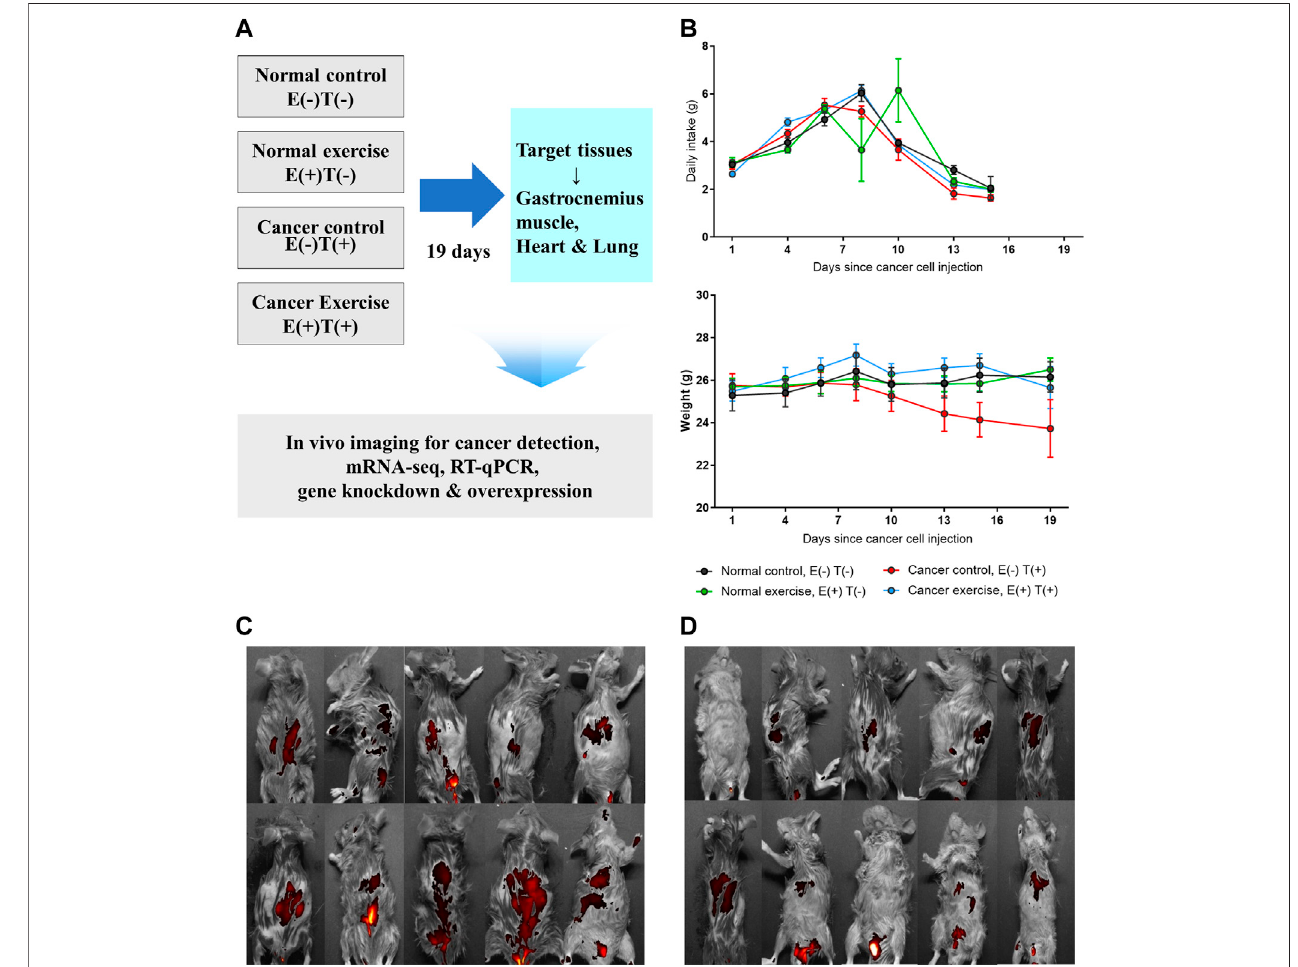
FIGURE1| Invivo animalmodeltostudythemoleculareffectofhigh-intensityaerobicexercise. (A) Inthecurrentstudy,40miceweredividedintofourgroupsoften mice each (normal control, normal exercise, cancer control, and cancer exercise). The changes of daily intake and weight of each group were traced for 19 days. After 19 days, invivo imagesfordetectingCT-26-derivedcancermetastasisweretakenforcancer-bearingmice,andtissueswereisolatedfordetectingproteins,mRNA-seq, RT-qPCR, in vitro gene downregulation and/or overexpression analyses. (B) Average daily food intake and weight changes of mice from each group during the 19 days of the experiment. Statistical differences ( p = 0.007 for food intake and p = 0.001 for weight changes) in the interaction between the number of days and the group are shown. (C,D) In vivo images showing that cancer metastasized the whole mice in cancer control (C) and cancer exercise mice used in this study (D)